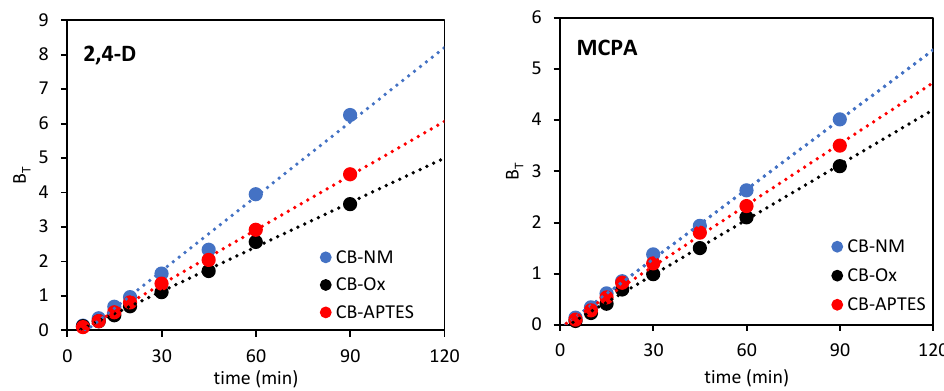
Figure 8. Boyd kinetic model plots for adsorption of 2,4-D and MCPA on carbon black samples.